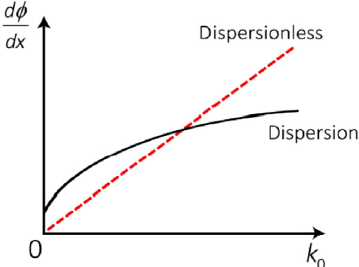
Fig. 3. Schematic illustration of dispersionless phase front. A dispersionless phase front should have d f / dx proportional to k 0